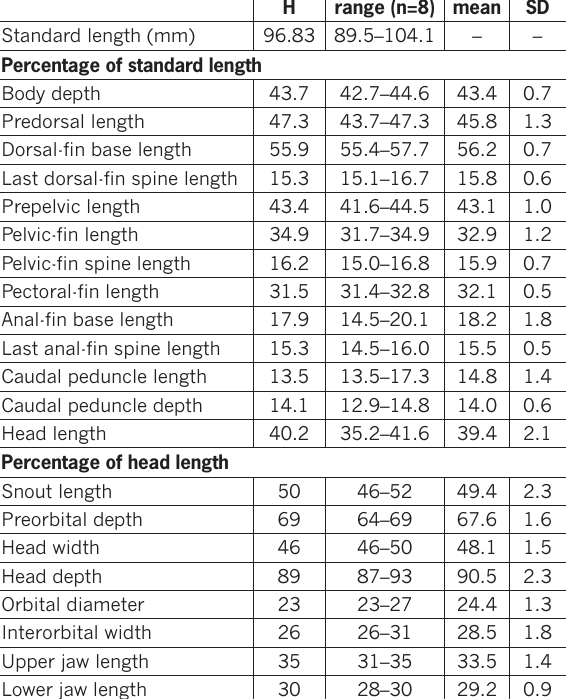
Table 2. Morphometric data of G. rufomarginatus . H, holotype; SD, standard deviation. Values of holotype included in